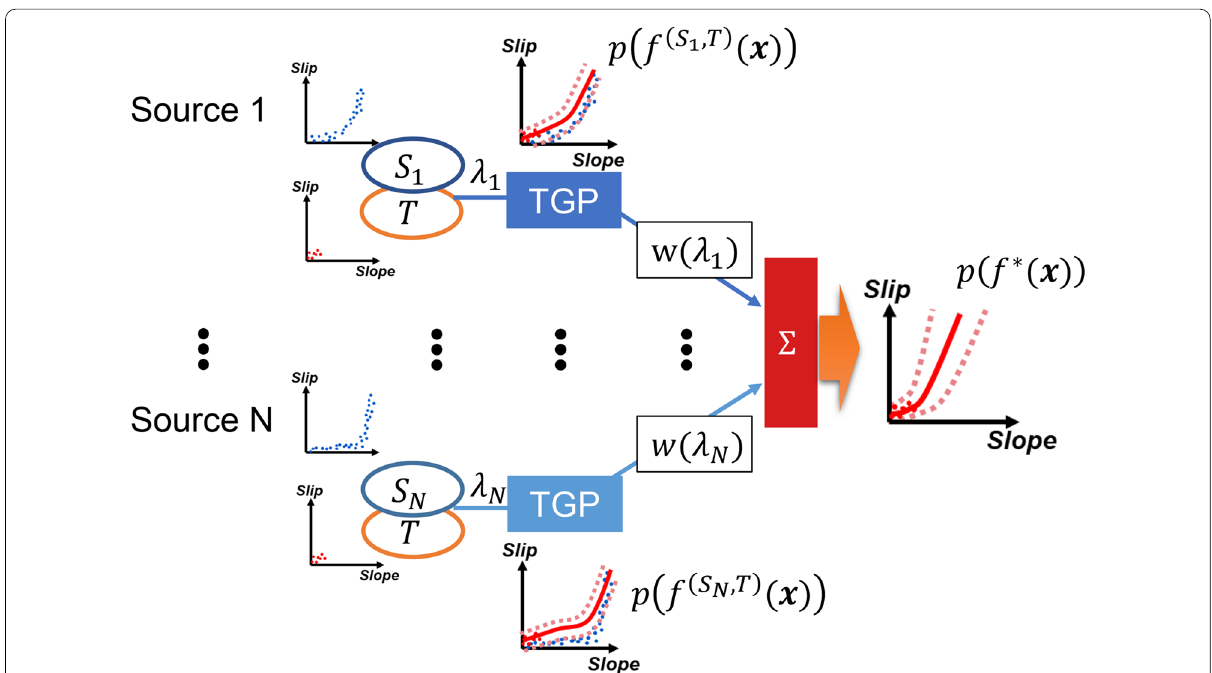
Fig. 2 Outline of traversability model learning based on multi-source transfer Gaussian process regression [6]. The domain similarity (cid:31) i between each source S i and target T domain, as well as the single TGPR model between them, are learned from the data present in S i and T . The prediction model for the target domain is then built as an ensemble of all TGPR models. The importance of each model is determined from (cid:31)